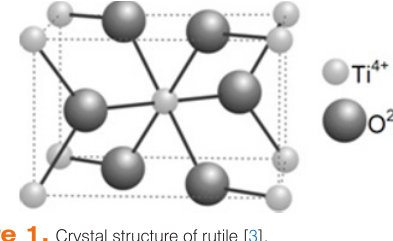
Figure 1. Crystal structure of rutile